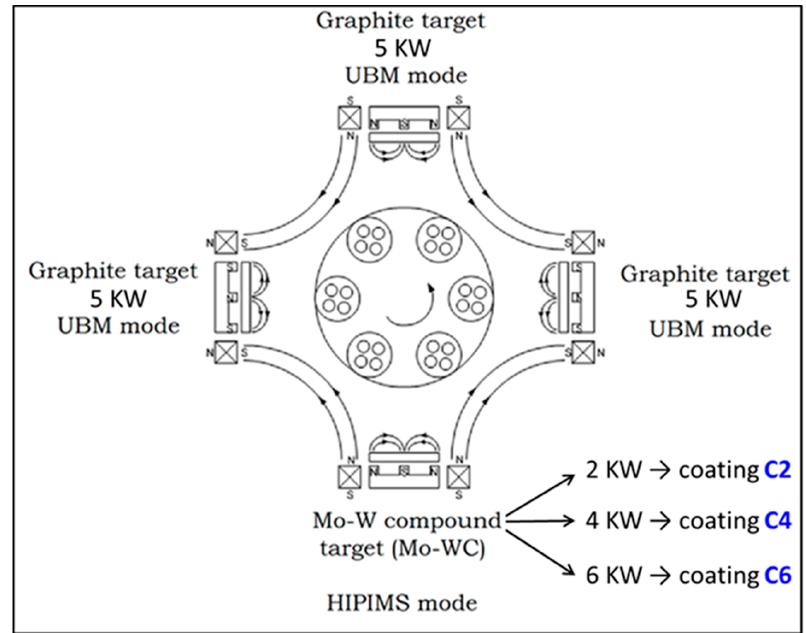
Figure 1. Schematic showing deposition of Mo-W-C coatings—C2, C4 and C6 .